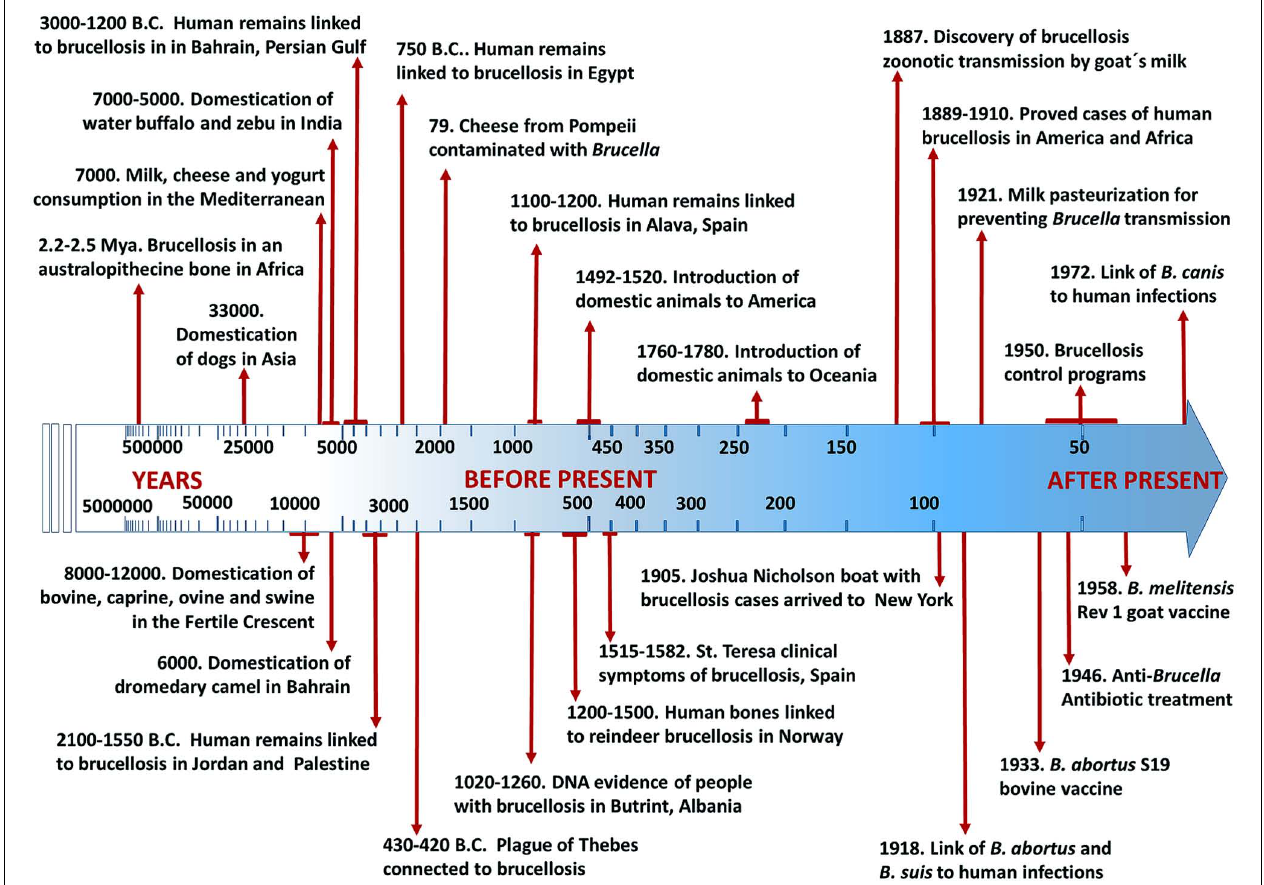
FIGURE 4 |Timeline of events associated with zoonotic brucellosis. The scale increases logarithmically from 5 million years in the past to 50 years estimated as the “present” (in 1950). Dates are designated as indicated in the main text.